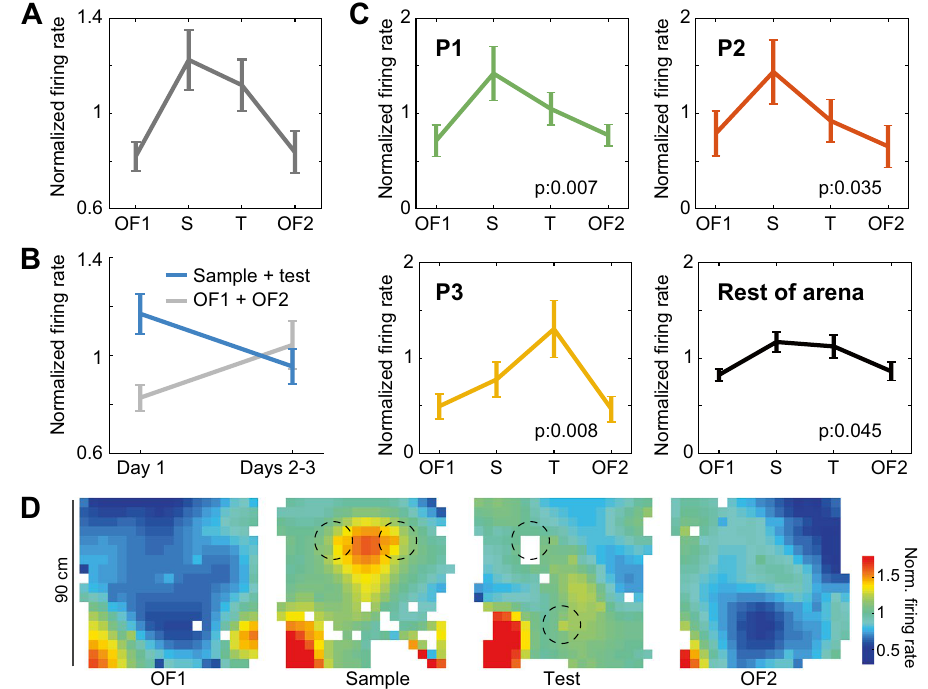
Figure 5. Cells exhibit a combination of global and local response to the novel placement of objects. ( A ) Distribution across sessions of the mean normalized firing rate for 18 neurons recorded on day 1 (mean ± s.e.m.; Kruskal–Wallis test H(3): 9.6, p: 0.023). ( B ) As ( A ) but pooling sessions with (blue) and without (grey) objects across days. A significant difference was found in Day 1 (Wilcoxon test z: 2.96, p: 0.003). ( C ) Similar plots for circles 10 cm in radius around each position (indicated) or for the rest of the maze across sessions of day 1. Significance of a Kruskal–Wallis test comparing sessions indicated (P1 p: 0.007, P2 p: 0.035, P3 p: 0.008, Rest of maze p: 0.045). ( D ) Mean normalized maps for all sessions on day 1. Circles 10 cm in radius used for analyses are indicated (dashed lines). Note that smoothing in these maps has the purpose of improving visualization, and does not affect results in ( A – C ), where no binning or smoothing was